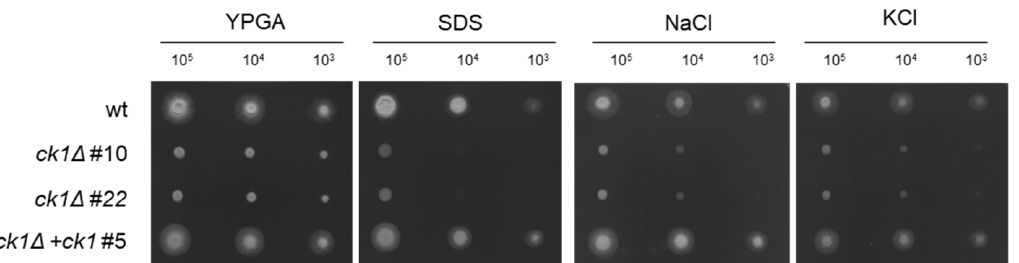
Figure 3. Ck1 contributes to the response to membrane and hyperosmotic stress. Aliquots of 10 5 , 10 4 , and 10 3 fresh microconidia of the indicated strains were spot ‐ inoculated on YPGA plates in the absence or presence of 0.075% ( w/v ) SDS, 1.2 M NaCl, or 1.2 M KCl. The plates were imaged after two days of incubation at 28 °C. Images are from one representative experiment. Experiments were performed twice, each with three independent plates per growth condition.